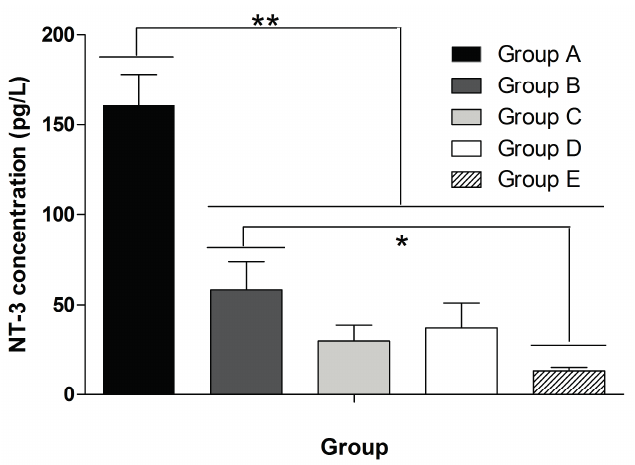
Figure 7. The concentration of NT-3 in the culture supernatant was detected by ELISA. Group A, after trypsinization, OEC were placed onto slides and cultured in 10% FBS for 7 days; Group B, after trypsinization, OEC were cultured in RS (concentration:10%) for 7 days; Group C, after trypsinization, OEC were cultured in 10% FBS for 3 days and then cultured in 10% RS for another 4 days; and Group D, after trypsinization, OEC were placed onto slides, cultured in 10% FBS for 3 days, and then cultured in 10% RS for another 4 days. Group E, the OEC were first cultured in 10% FBS for 3 days and then cultured with rat spinal cord explants with 10% RS for another 4 days. The data was presented as mean ± SD. There was statistically significant difference between Group A and Group B, Group A and Group C, Group A and Group E. Significant difference was also detected between Group B and Group E. The data was presented as mean ± SD. One asterisk means that there is statistically significant difference and p < 0.05. Two asterisks mean that there is statistically significant difference and p < 0.01.